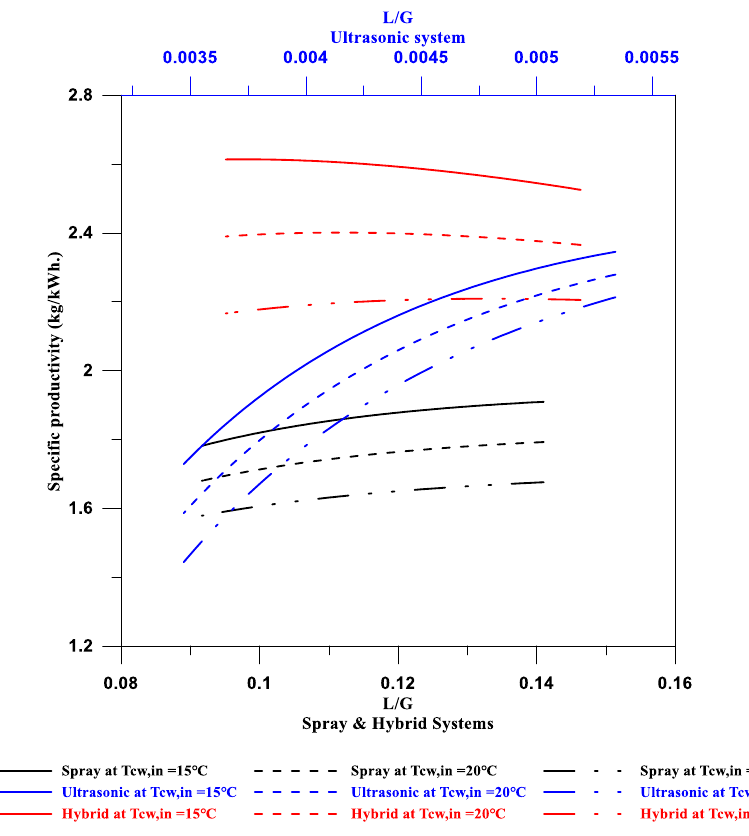
Figure 15. Specific productivity of the three systems at different T cw,in.